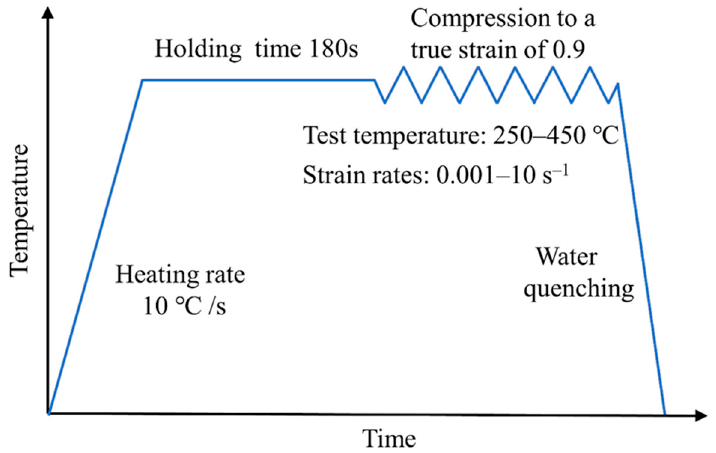
Figure 1. Scheme of the hot compression test.